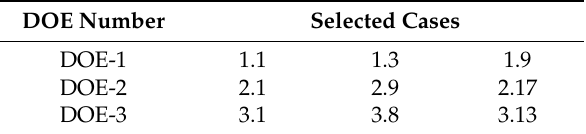
Table 7. Selected top three optimal design cases for DOE 1, 2 and